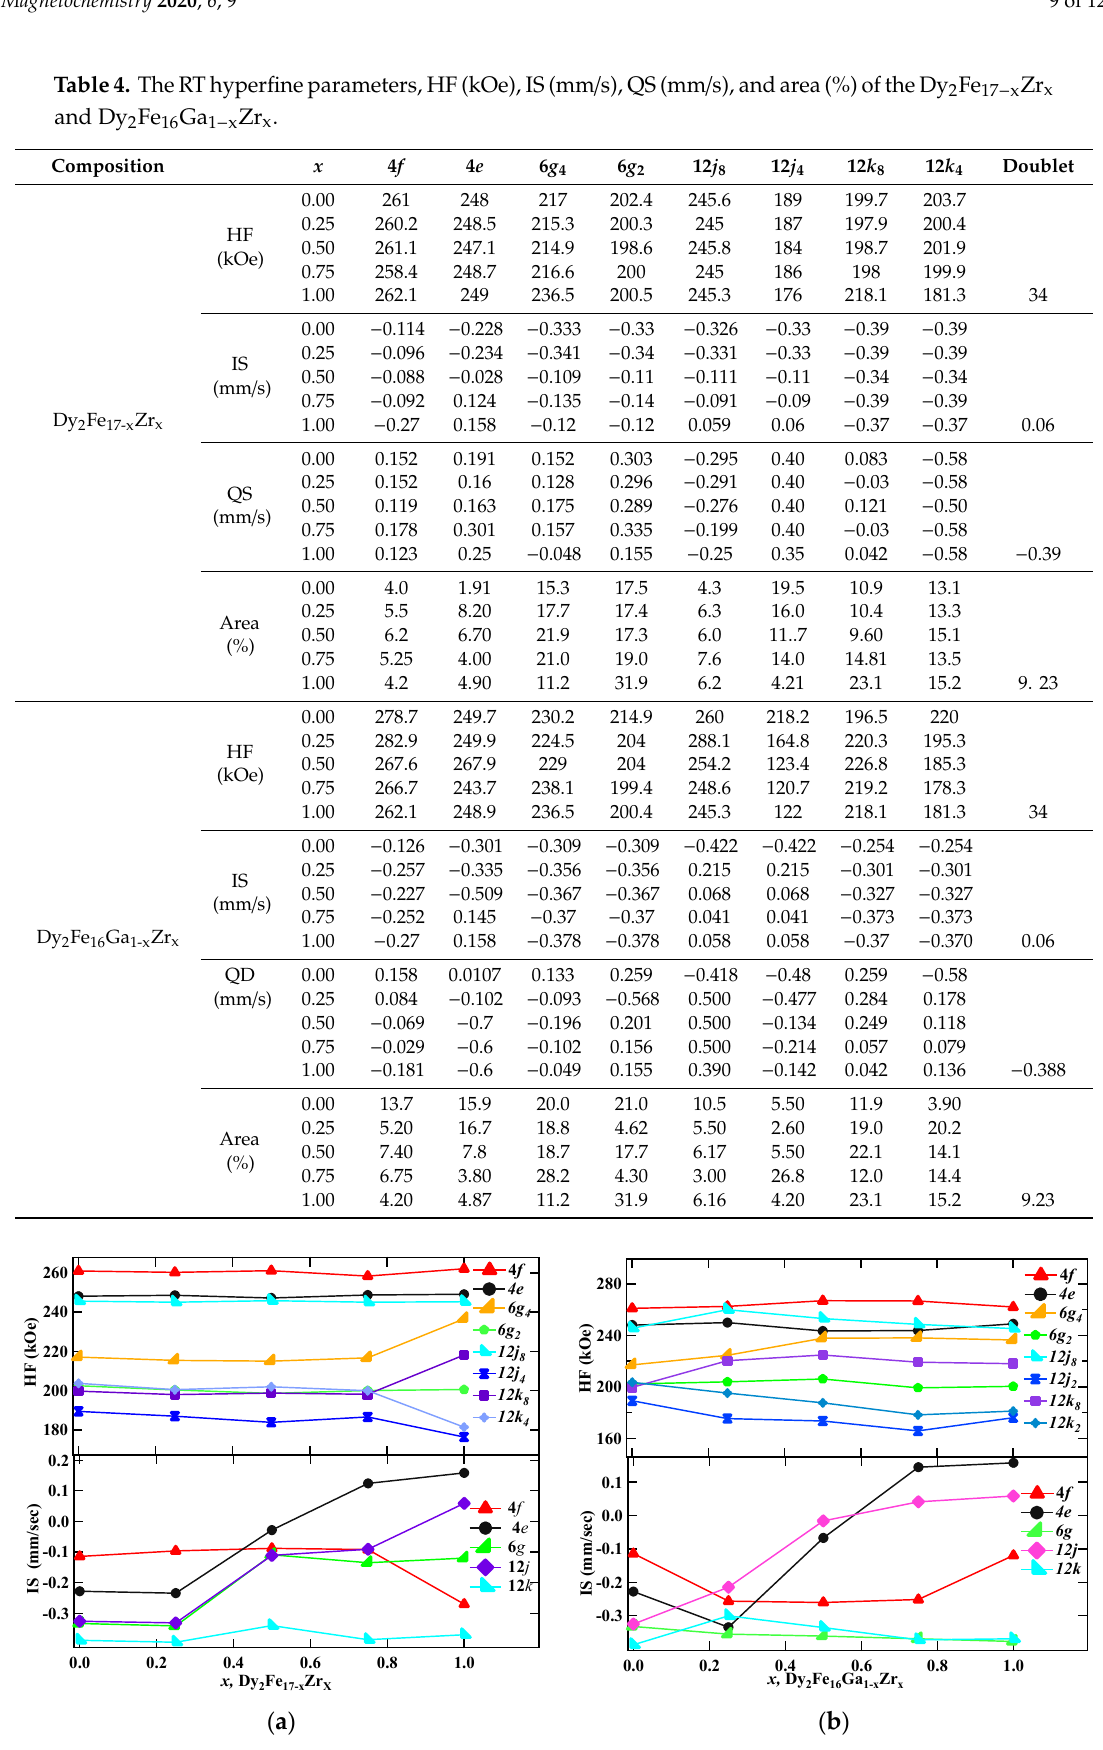
Figure 8. RT Mössbauer hyperfine parameters plots for ( a ) Dy 2 Fe 17 − x Zr x , and ( b ) Dy 2 Fe 16 Ga 1 − x Zr x .